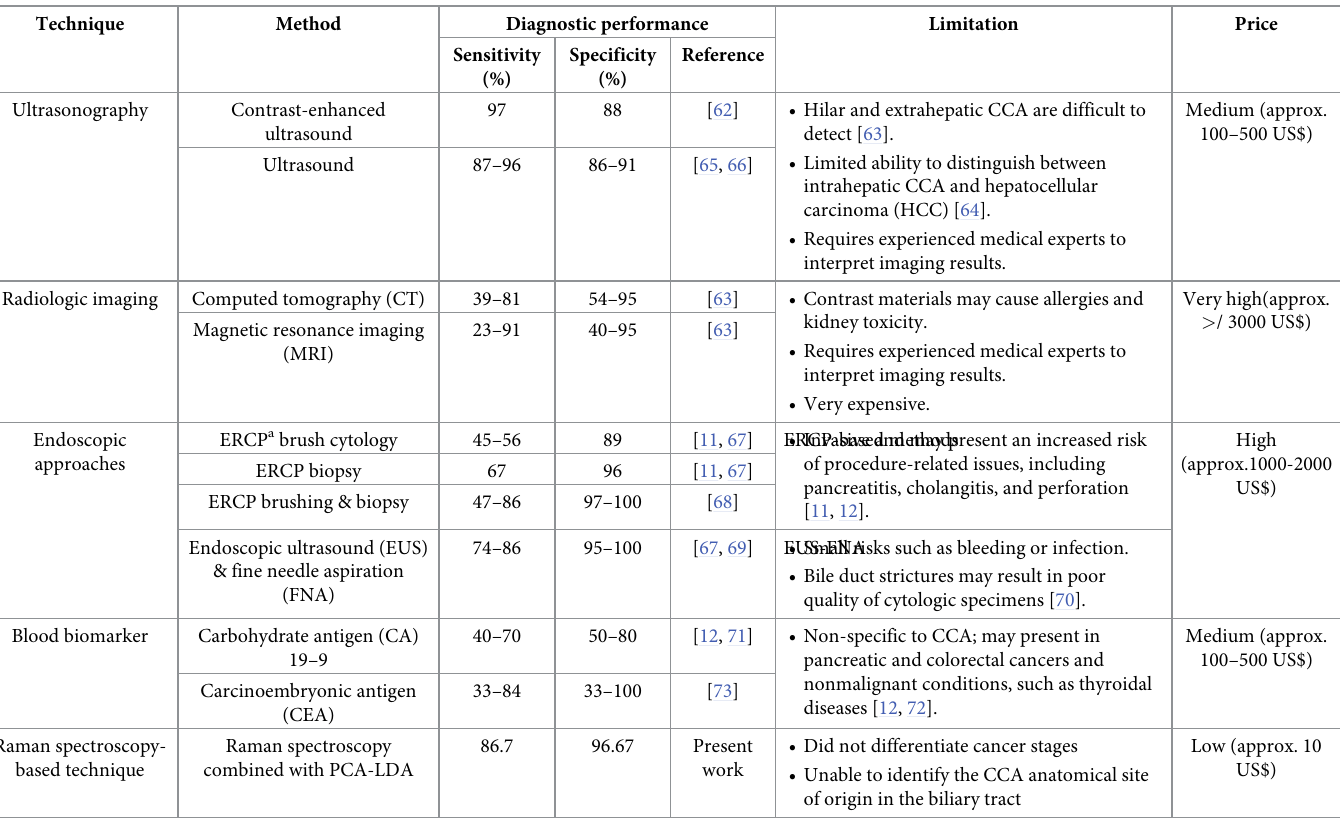
Table 3. Comparison of current diagnostic methods for cholangiocarcinoma